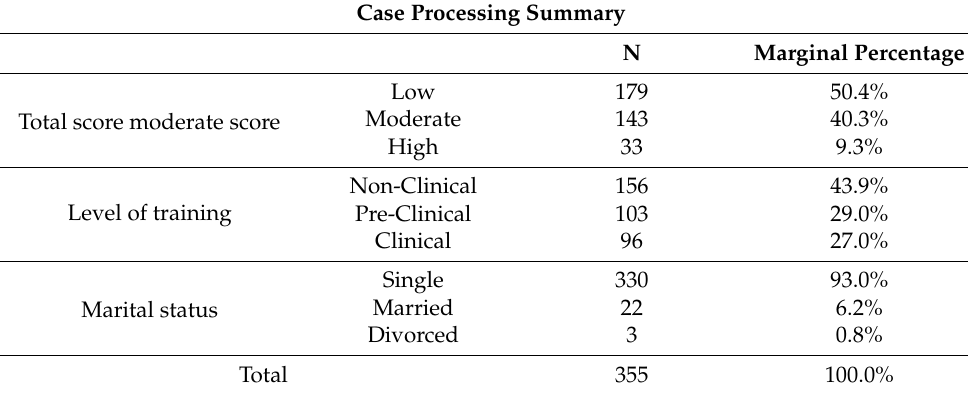
Table 4. Knowledge score prediction based on marital status and clinical